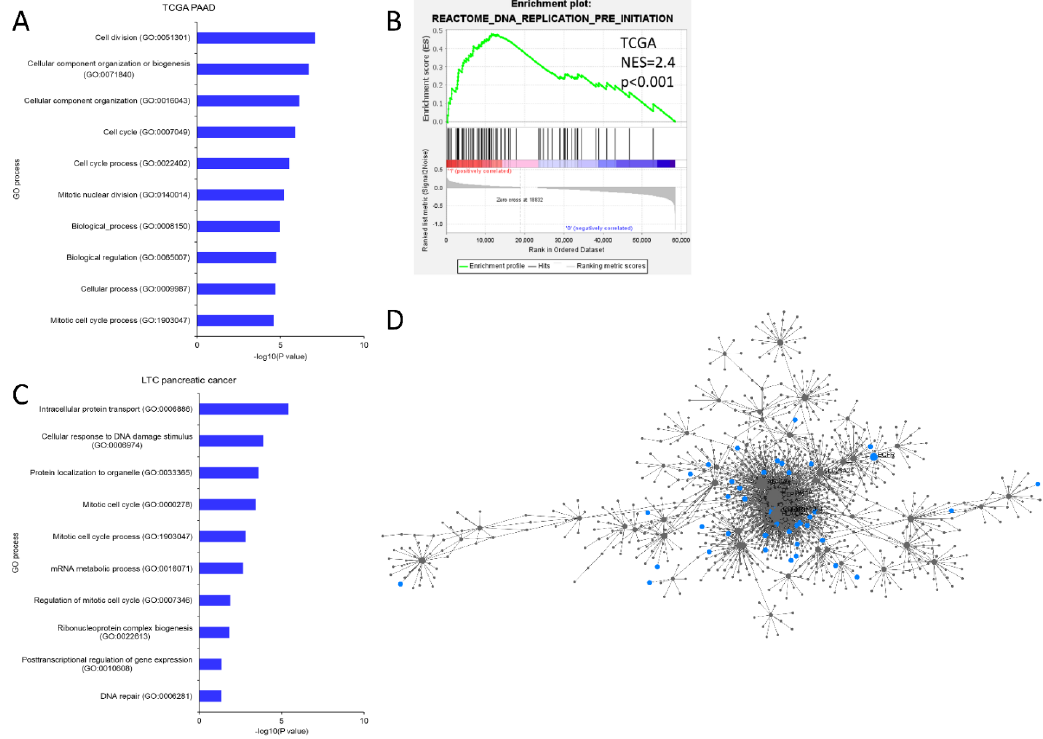
Figure 2. RNA sequencing reveals the alteration of cell cycle progression in SEMA6C-low pancreatic cancer. RNA sequencing results from TCGA ( A , B ) or the present study ( C , D ) were analyzed for SEMA6C-associated pathway ( A , C ), gene set ( B ), and network ( D ). 2.3. SEMA6C Inhibited the Growth of Pancreatic Cancer Cells